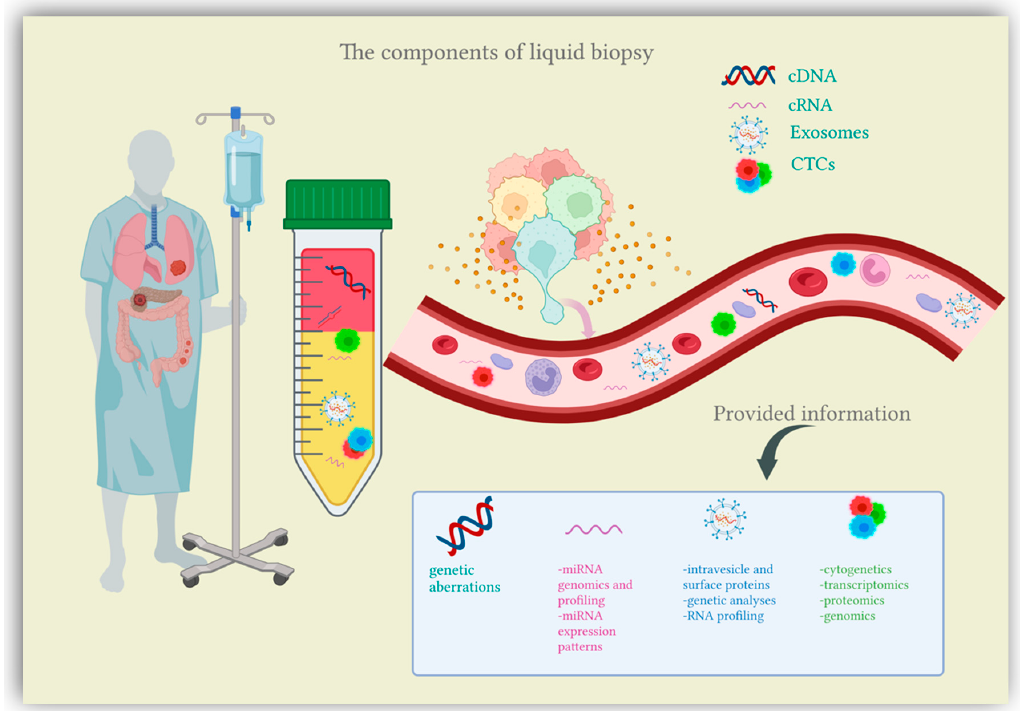
Figure 1. The components of liquid biopsy. Circulating DNA (cDNA), circulating RNA (cRNA), exosomes and circulating tumor cells (CTCs) are shed into the bloodstream directly from the tumor mass or metastases. Following blood sample collection, these components are further analyzed to provide extensive tumoral characterization.